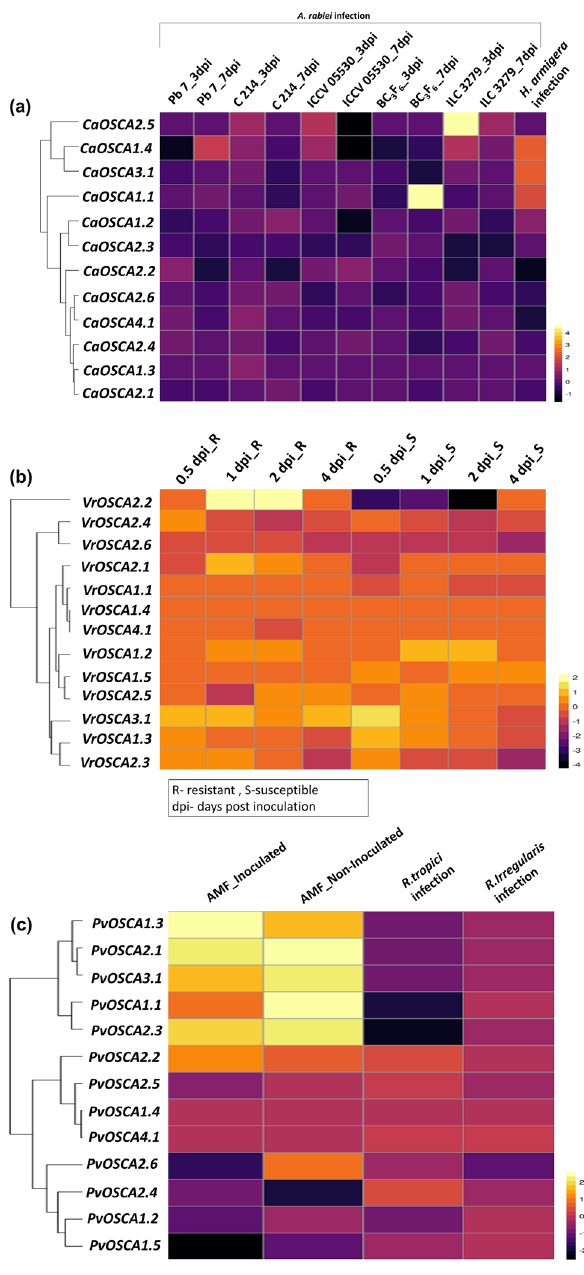
Figure 8. Expression profiles of OSCA genes in different biotic stresses. The genes are named on the left, and condition/tissue is labelled at the top. The scale bar represents the log_2 Fold Change based on FPKM values; ( a ) Expression pattern of CaOSCA genes under Ascochyta rabiei infection in five chickpea cultivars; under Helicoverpa armigera infection; ( b ) Expression pattern of VrOSCA genes under Fusarium oxysporium infection at four different time points. ( c ) Expression pattern of PvOSCA genes under the cumulative effect of drought stress and AMF; and Rhizobium tropici and Rhizophagus irregularis